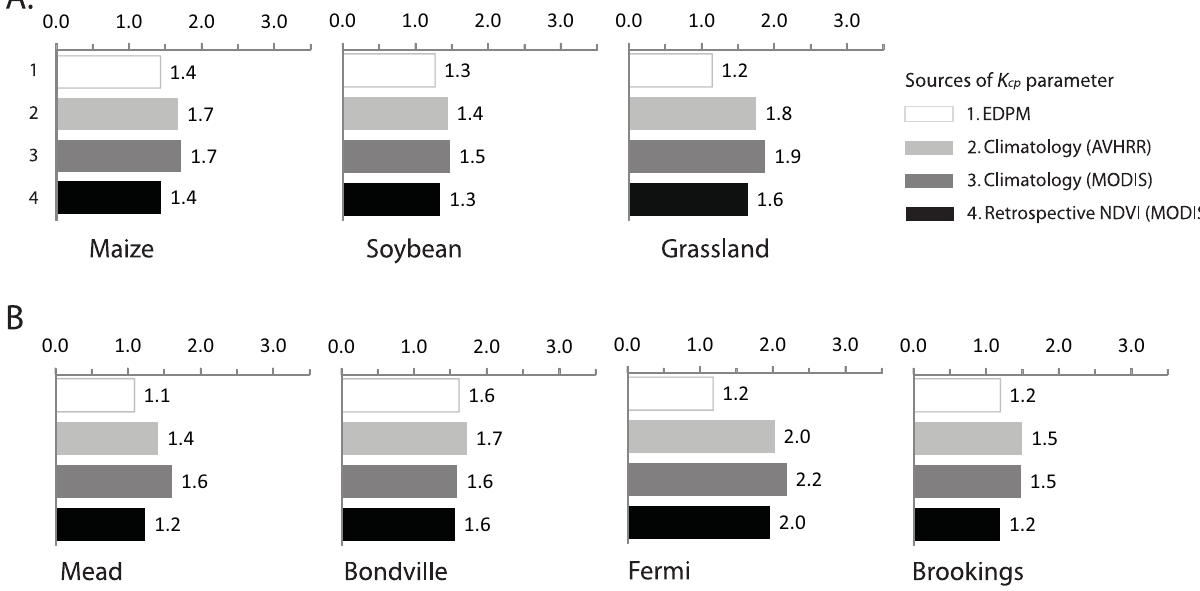
Fig. 5. Root Mean Squared Errors produced by different evapotranspiration estimates: arranged (A) by vegetation/crop type and (B) by